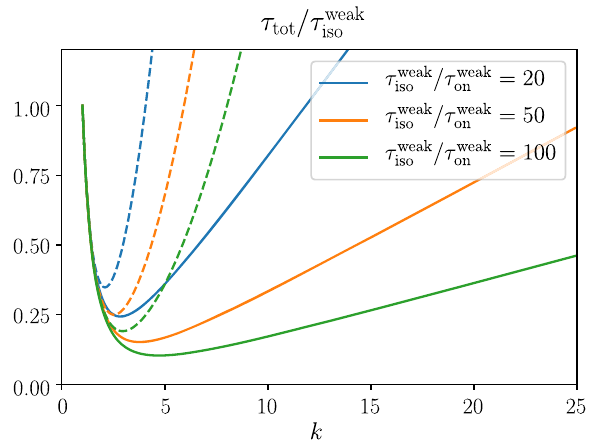
FIG. 2. The total time τ in Eq. (26) as a function of k , for total = τ weak different values of T ¼ τ weak : T ¼ 20 (blue), T ¼ 50 on iso (orange), T ¼ 100 (green), and α ¼ 1 . The dashed line corre- sponds to F ð 2 Þ and the solid line to F ð 1 Þ . Results for both F ð 2 Þ and F ð 1 Þ are exact, the former being obtained through the exact integral expression